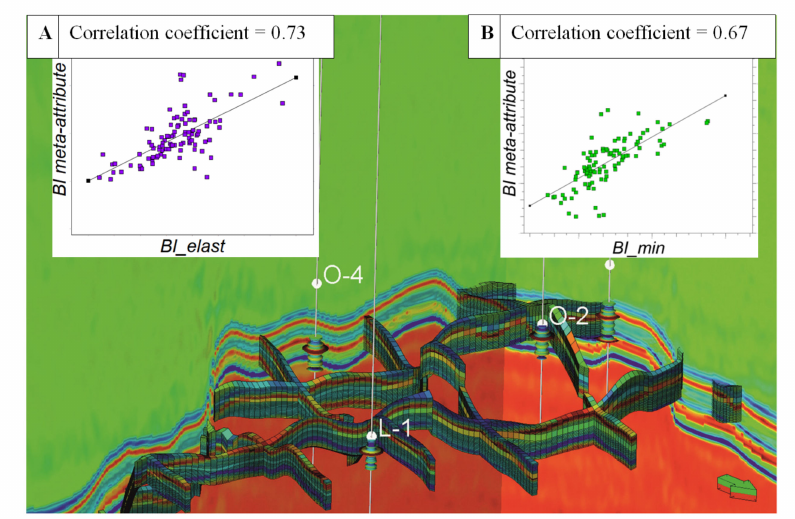
Figure 4. Meta-attribute of pseudo brittleness index shown on a seismic profiles in the background and grid property together with the calculated in the boreholes well logs of BI, as well as correlation between BI meta-attribute and ( A )—BI elast and ( B )—BI min .